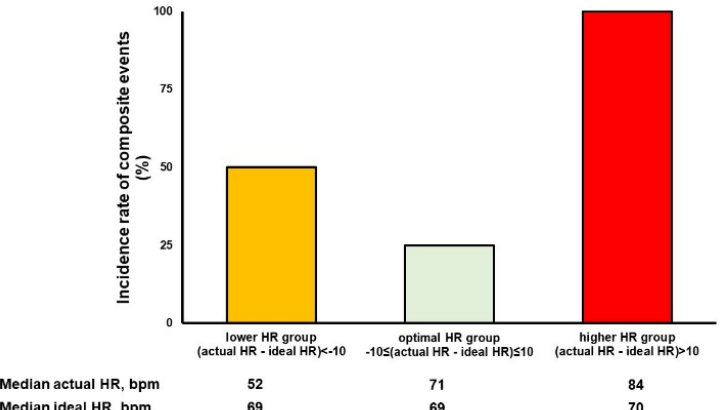
Figure 4. The incidence rate of primary endpoints stratified by the HR difference. The lower HR group: (actual HR − ideal HR) < − 10 bpm; the optimal HR group: − 10 bpm ≤ (actual HR-ideal HR) ≤ 10